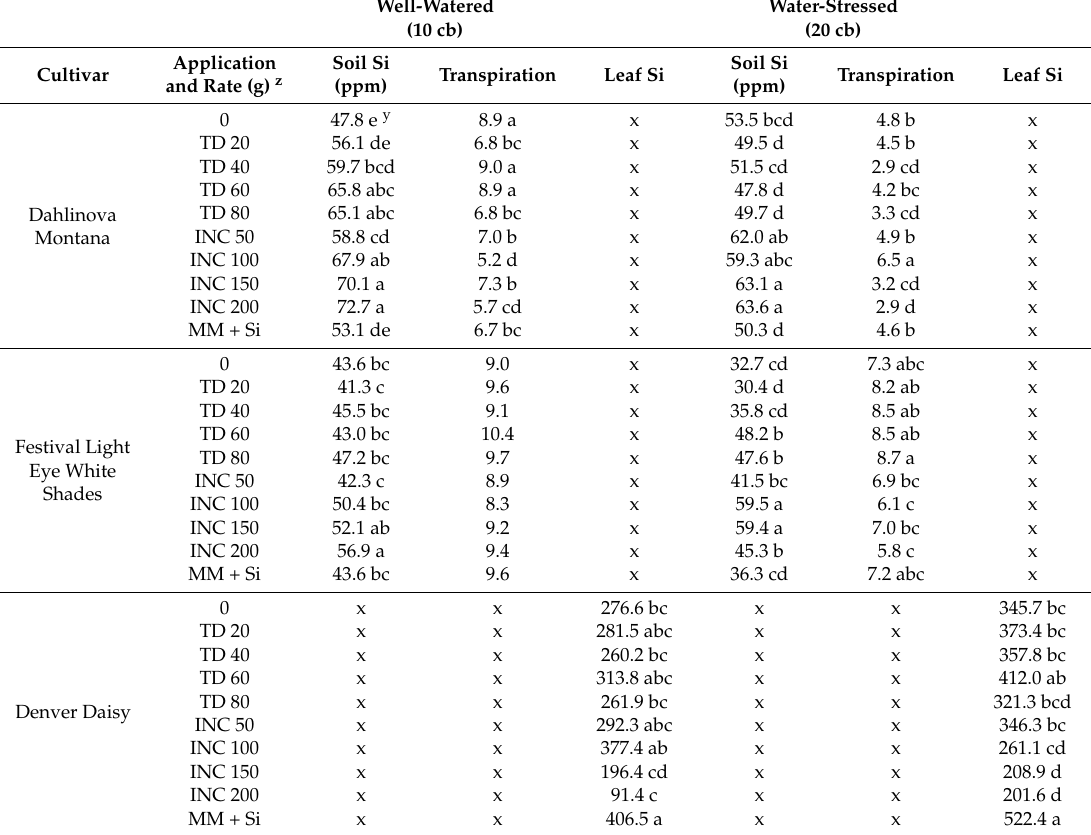
Table 2. Soil silica (Si), transpiration, and leaf Si affected by interaction of diatomaceous earth treatment with irrigation in Dahlia × hybrida ‘Dahlinova Montana’, Gerbera jamesonii ‘Festival Light Eye White Shades’, and Rudbeckia hirta ‘Denver Daisy’.